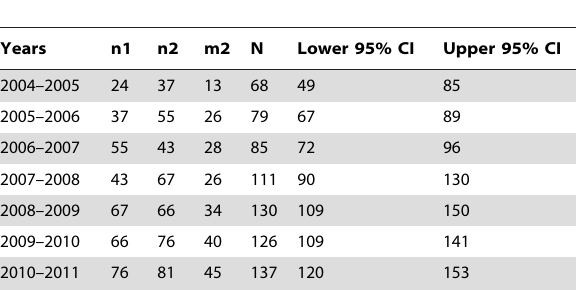
Table 1. Abundance estimates of whales individually identified in each year.